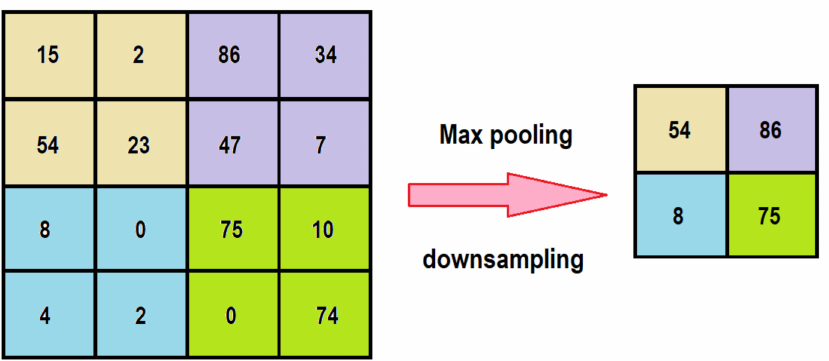
Figure 13. Maximum pooling process.